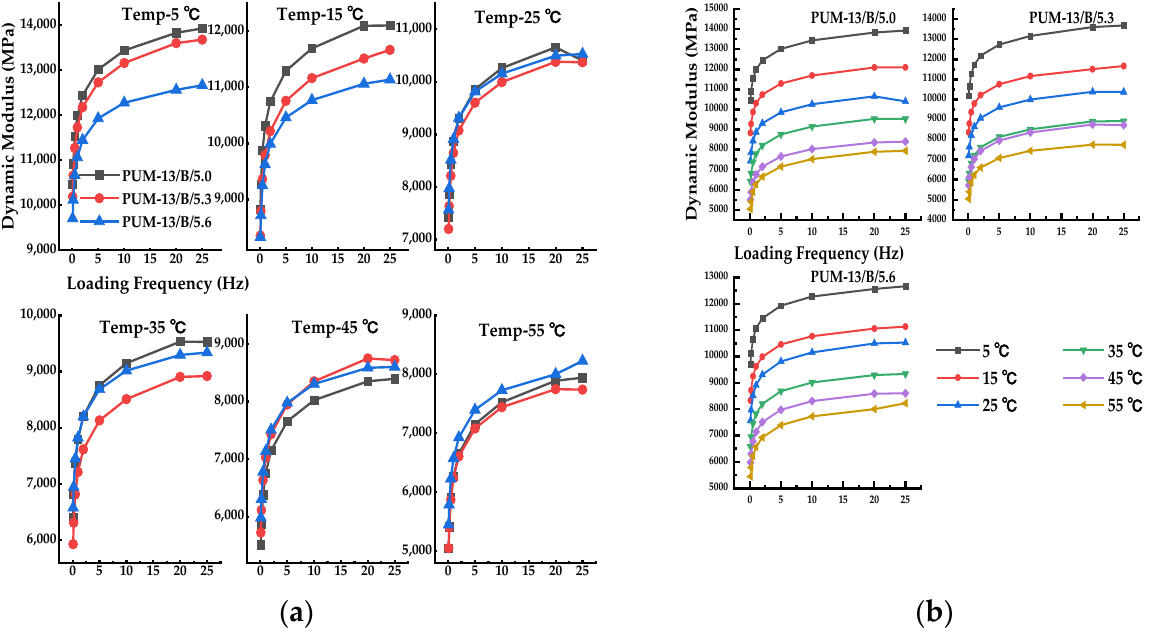
Figure 10. The dynamic modulus of the PU mixtures with the same gradation and different PU contents. ( a ) dynamic modulus under different test temperatures, ( b ) dynamic modulus with different PU contents.